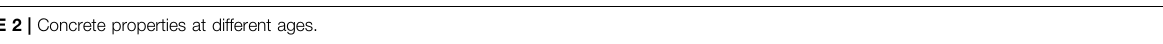
TABLE 2 | Concrete properties at different